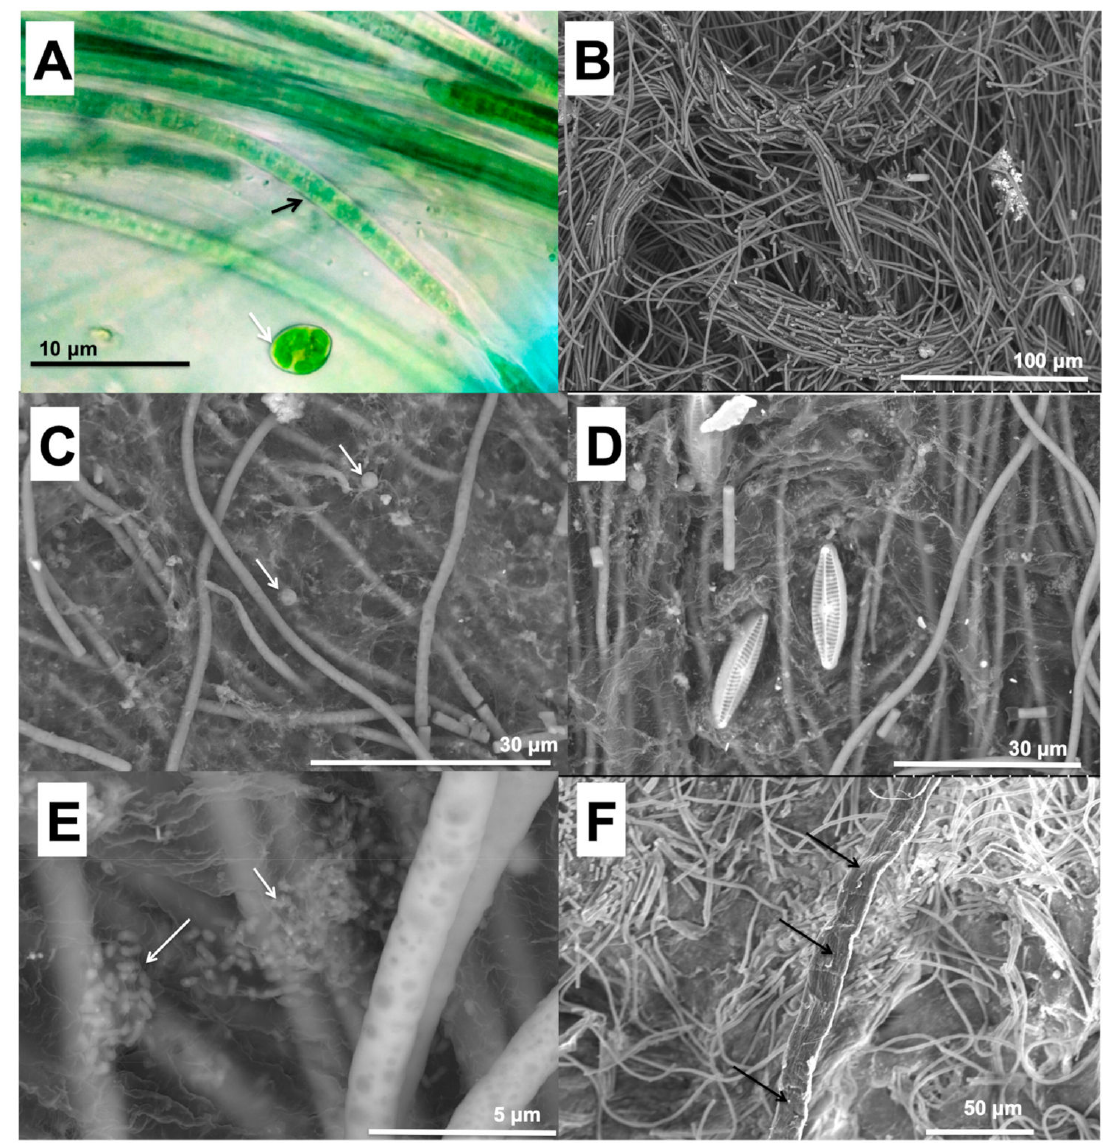
Figure 3. Images of ( A ) Filamentous ( Oscillatoriaceae ) (black arrows) and coccoid Gloeocapsa -like cyanobacteria (white arrows) viewed under light microscopy; SEM observations of ( B ) filamentous Oscillatoriaceae -type cyanobacteria, ( C ) coccoid Gloeocapsa -like cyanobacteria (white arrows) ( D ) pennate diatoms near cyanobacterial filaments in an EPS matrix, ( E ) presumably heterotrophic bacteria (white arrows) covered in EPS matrix and ( F ) a large cyanobacterial filament, likely a Phormidium sp. (black